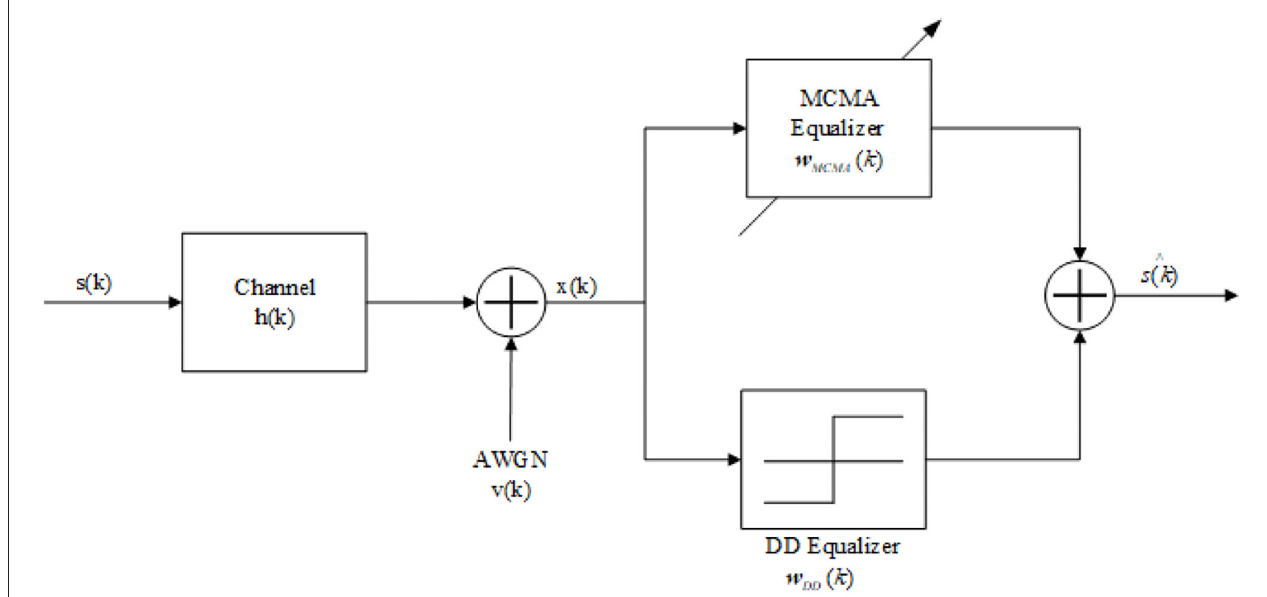
FIGURE 2 | The baseband model of the concurrent MCMA and DD BCE